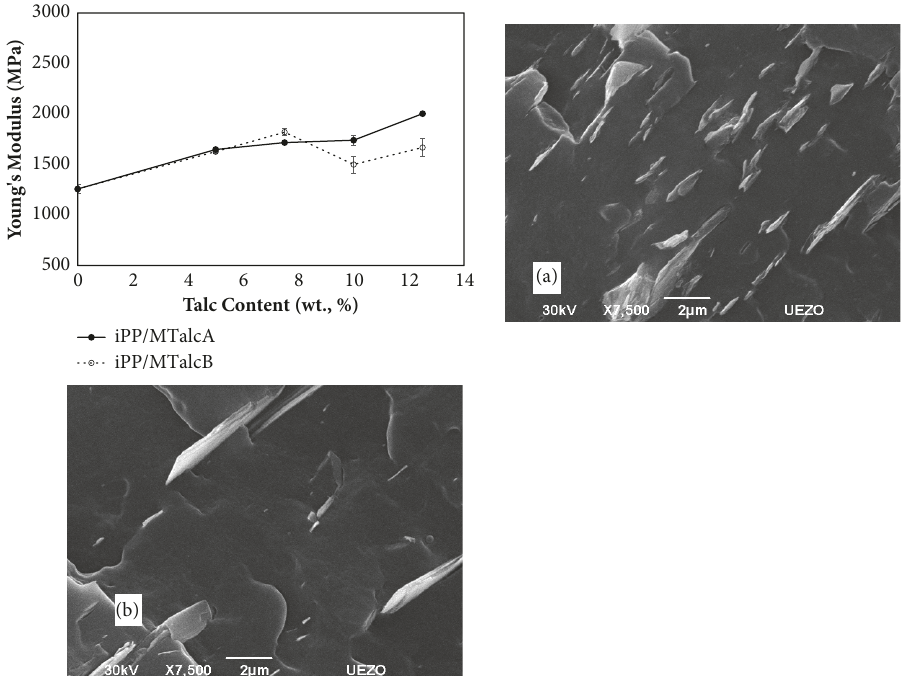
Figure 3: Young’s modulus x filler contentcurves of composites based on iPP/Talc, obtained by masterbatchdilution step. SEM micrographs: (a) iPP/MTalc A and (b) iPP/MTalc B.